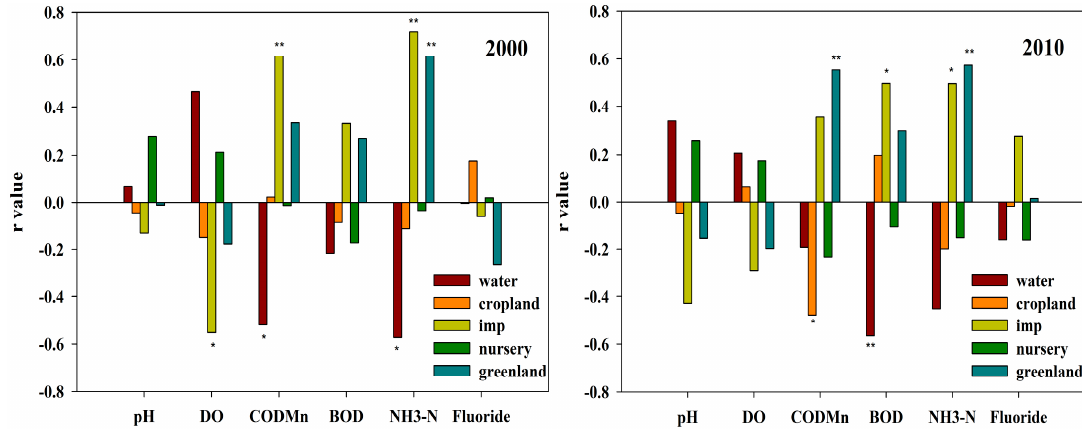
Figure 2. Pearson relationships between water quality and land use types within the 2000 m buffer in 2000 and 2010. “*” and “**” refer that the coefficients (r) are significant at the 0.05 level and at the 0.01 level, respectively.